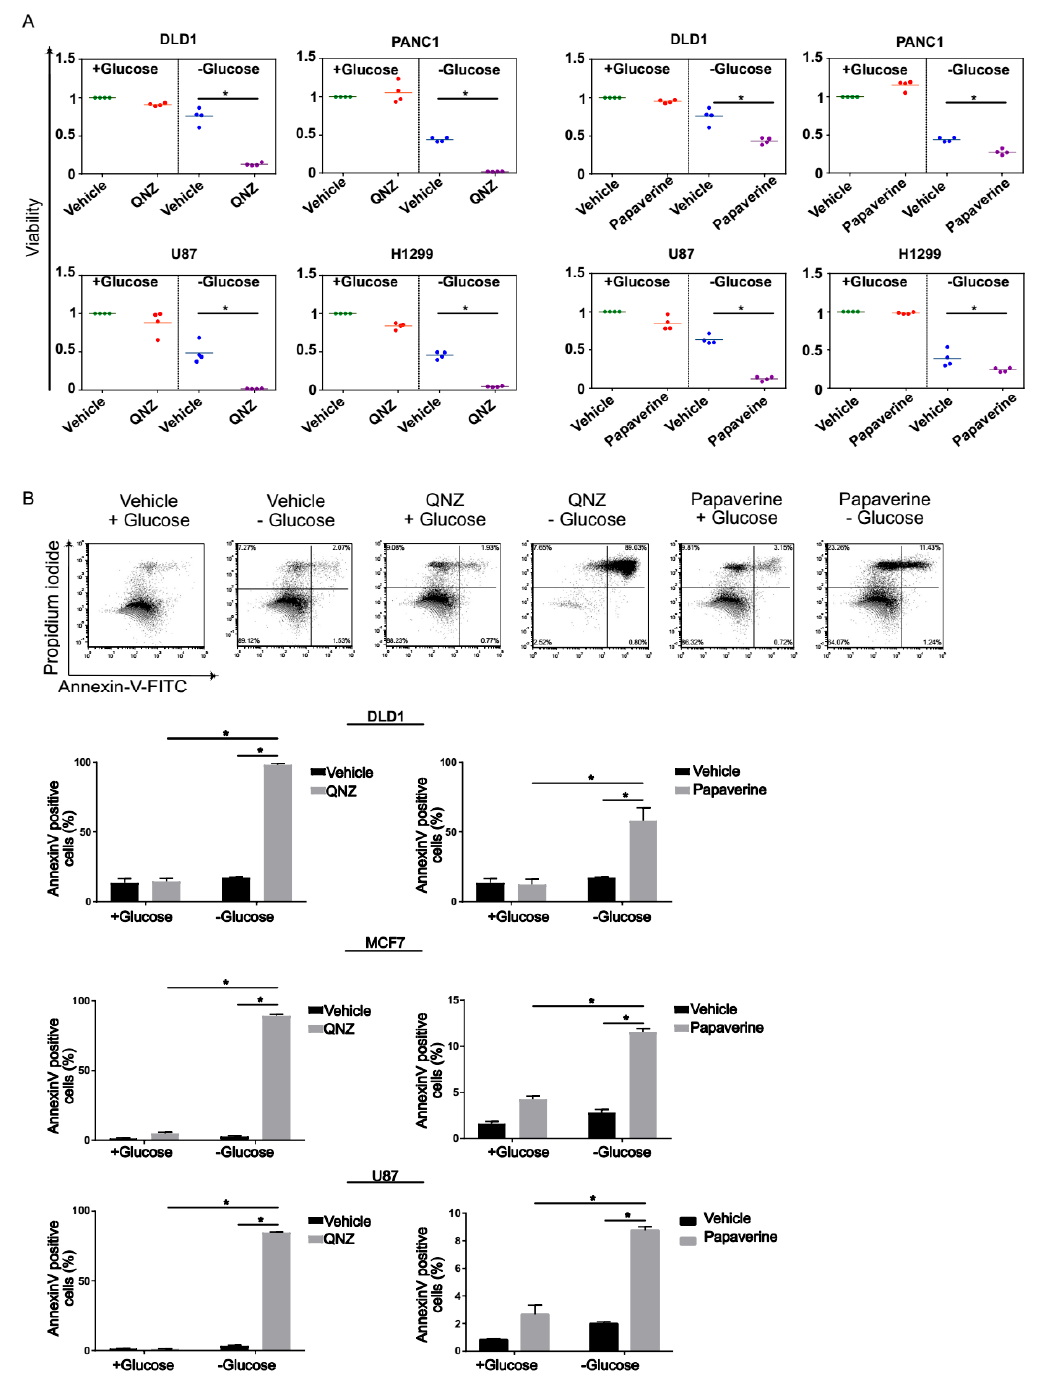
Figure 3. Selective killing of tumor cells under glucose starvation by QNZ and papaverine. ( A ) The viability of four tumor cell lines treated with QNZ (100 nM) or papaverine (3 µM) for 48 h under glucose starvation and normal conditions was determined using crystal violet staining. * p < 0.05. ( B ). Cell death of cells treated with the indicated compounds for 24 h in normal or glucose-starved medium was measured by annexin V/ Propidium iodide (PI) staining and fluorescence-activated cell sorting (FACS). Typical FACS plots obtained using MCF7 cells are shown. Data represent mean ± SD; * p < 0.05; n ≥ 3 independent experiments.